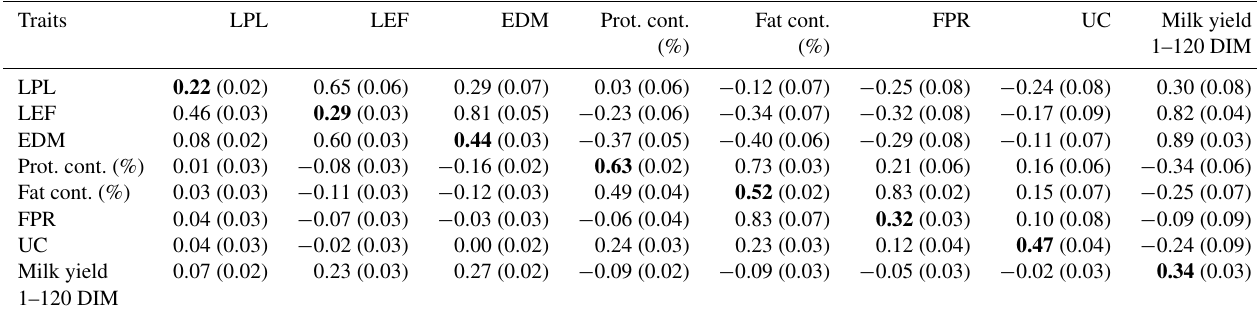
Table 6. Heritability, additive genetic correlations, and phenotypic correlations between lifetime productivity traits and milk yield during the first 120d of lactation.